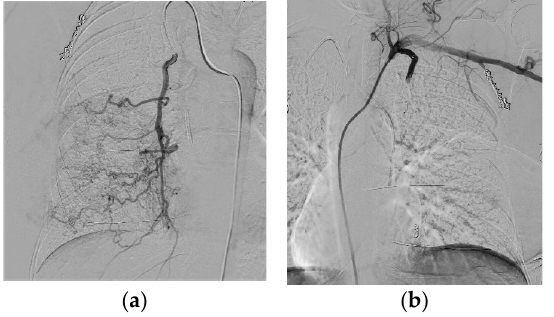
Figure 1. ( a , b ). Internal mammary artery in phase pre ‐ ( a ) and post ‐ ( b ) embolization. Figure 1a shows the arterial branches of the internal mammary artery responsible for breast bleeding; Figure 1b shows the disappearance of arterial branches after successful selective embolization procedure.